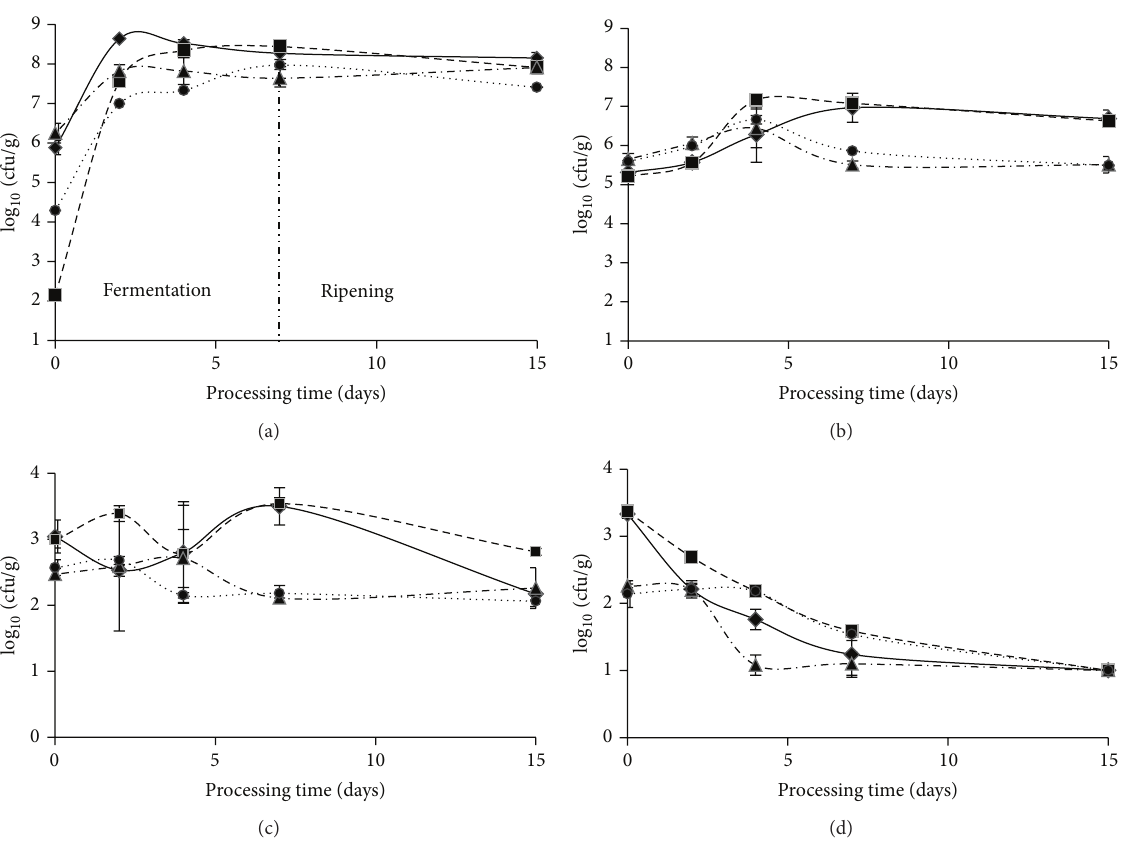
Figure 1: Bacterial counts of (a) lactic acid bacteria; (b) Micrococcaceae ; (c) yeasts and molds; (d) Enterobacteriaceae, throughout fermentation and ripening periods. Systems: X - X : SAS-1 ( Lactobacillus sakei 487 + Staphylococcus vitulinus C2); ◼ --- ◼ : C-1 (noninoculated control system simultaneously manufactured with SAS-1); 󳵳 - ⋅ - 󳵳 : SAS-2 ( L. sakei 442 + S. xylosus C8); e ⋅⋅⋅ e : C-2 (noninoculated control system simultaneously manufactured with